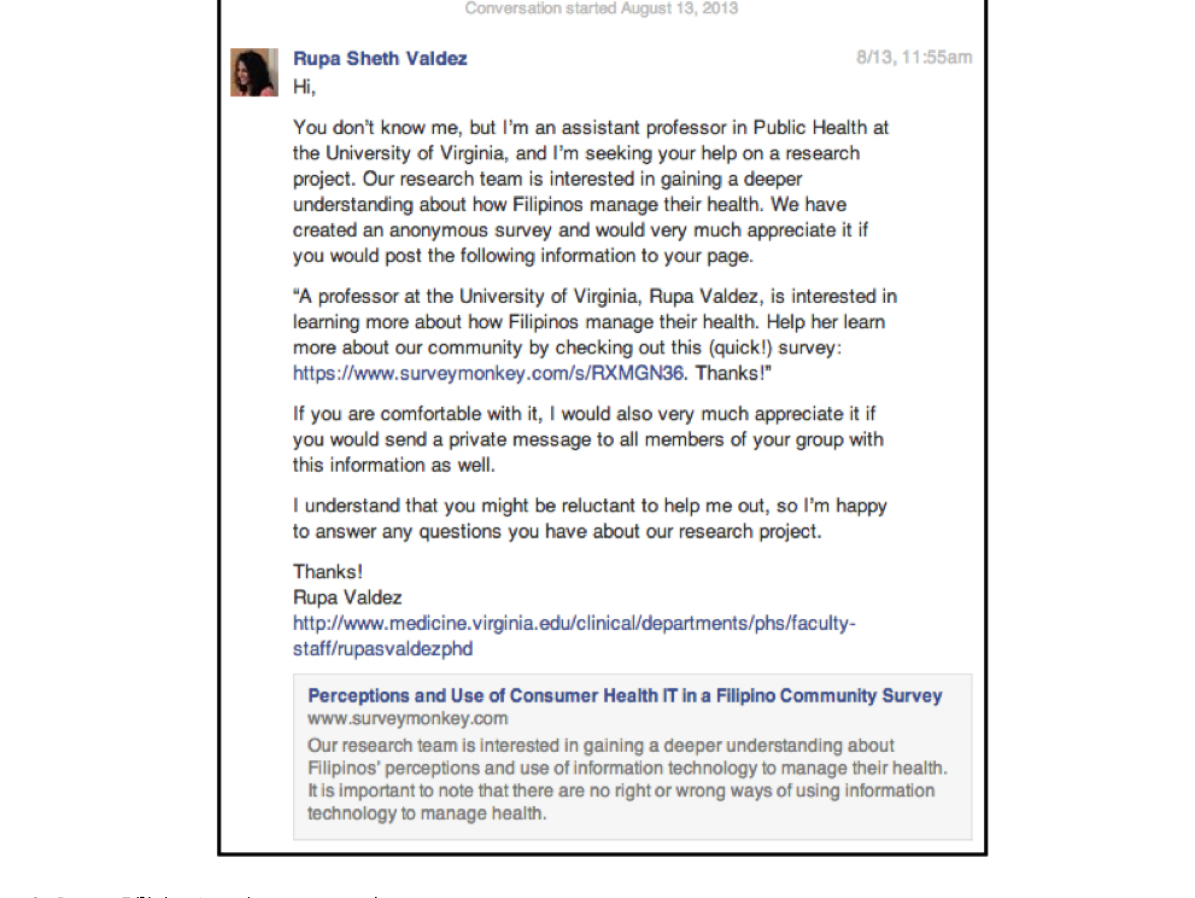
Figure 1. Message to Filipino-American group and page administrators.